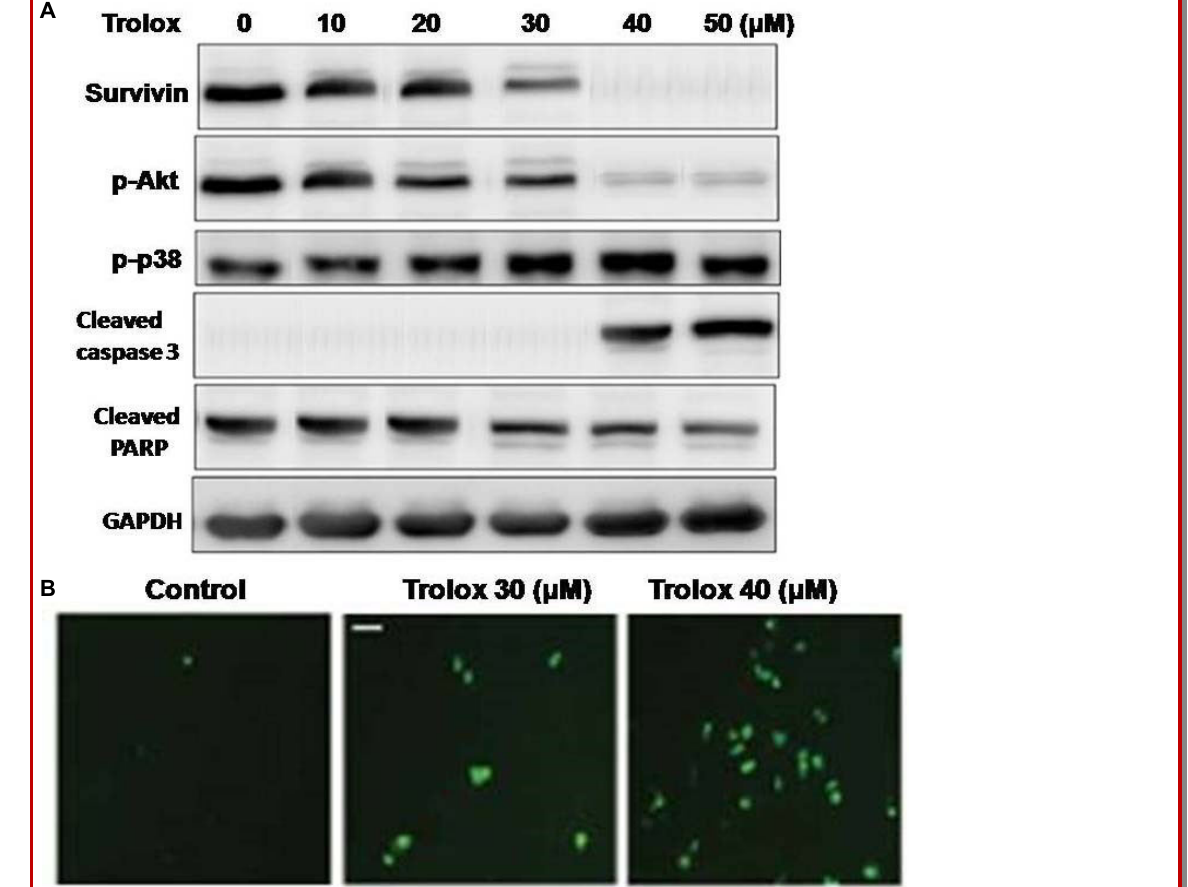
Figure 3: HCT-15 cells were treated with 10-50 µM of trolox for 24 hours followed by western blot analysis using GAPDH as the internal control (A) . HCT-15 cells were subjected to TUNEL staining following treatment with 0, 30 and 40 µM doses of trolox